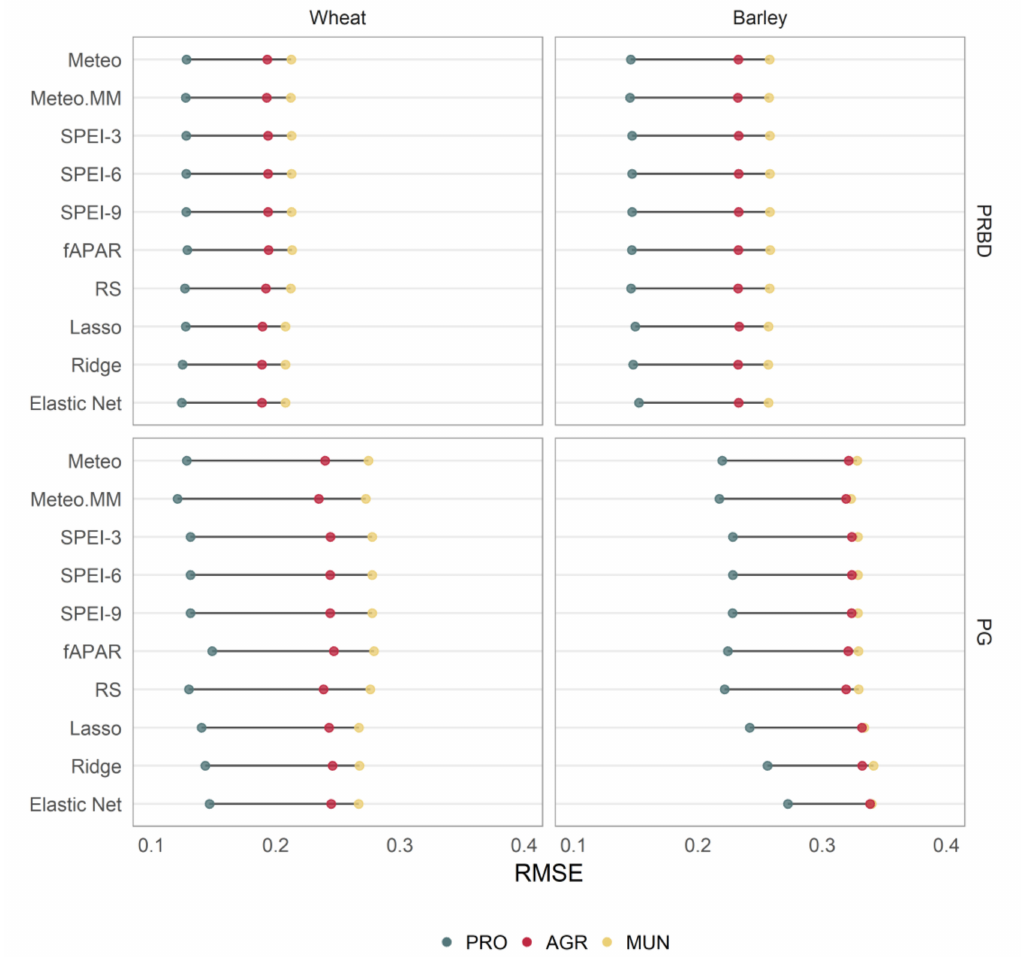
Figure 3. Average RMSE of the estimated models for wheat ( left ) and barley ( right ) in PRBD ( top ) and PG ( bottom ), resulting from cross-validation estimation over N = 1000 training-validation folds. Three di ff erent levels of spatial aggregation were considered: municipality (MUN), agricultural district (AGR) and province level